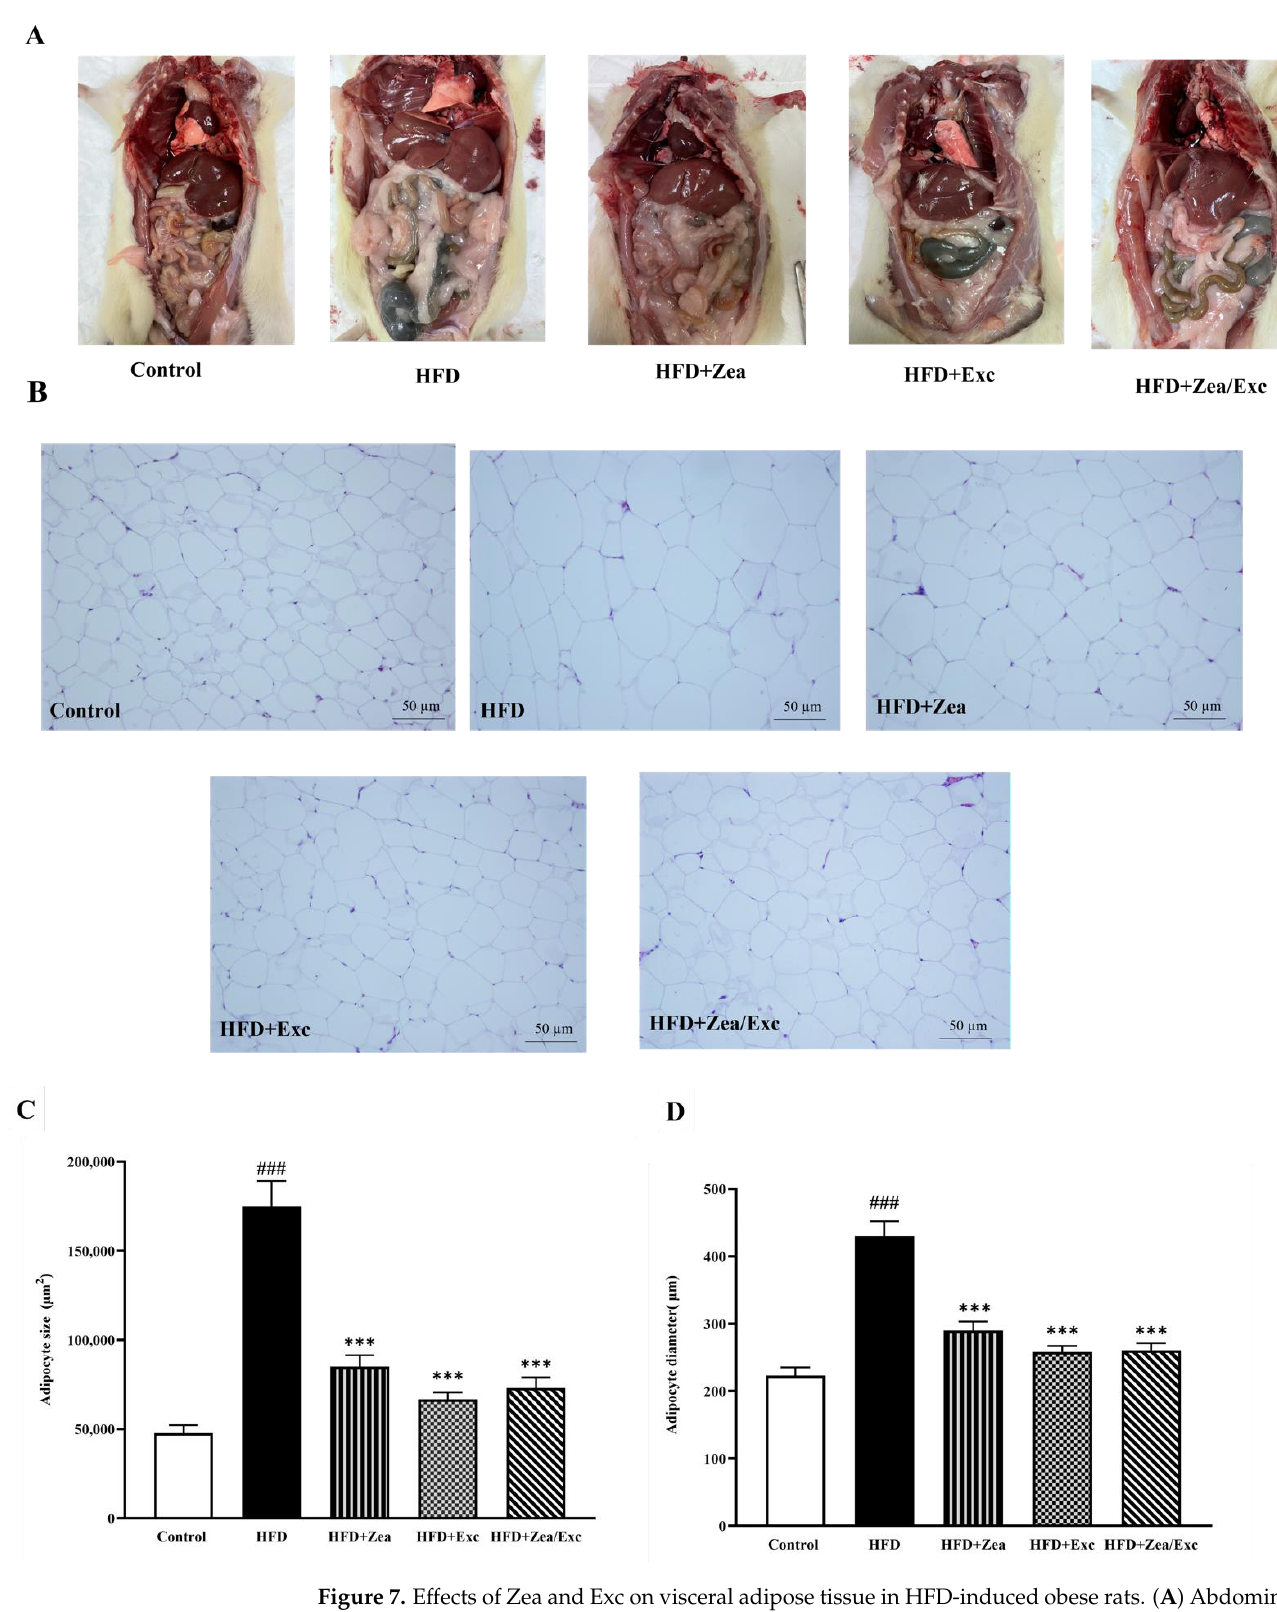
Figure 7. Effects of Zea and Exc on visceral adipose tissue in HFD-induced obese rats. ( A ) Abdominal cavity dissection of visceral adipose tissue; ( B ) histology of visceral adipose tissue; ( C ) adipocyte size; ( D ) adipocyte diameter. Data are expressed as means ± SEM, n = 4. ### p < 0.001 vs. control; *** p < 0.001 vs. HFD; 20× magnification.